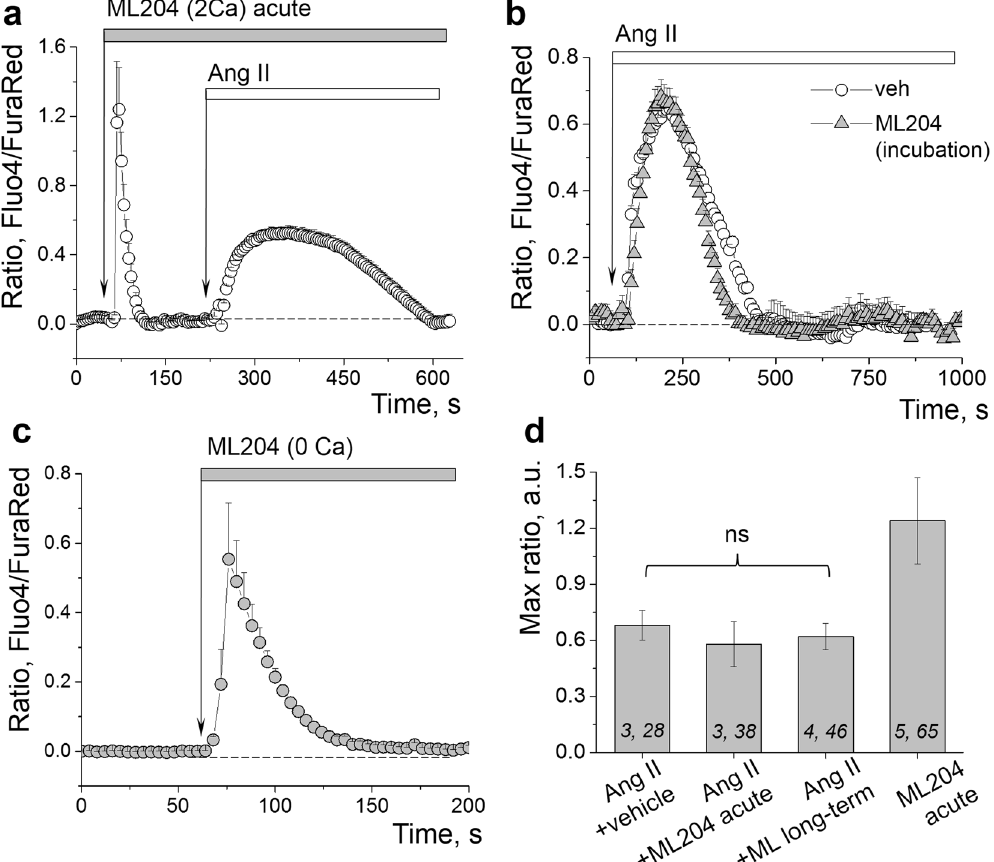
Figure 7. The effects of ML204 on calcium influx in the podocytes. ( a ) The representative effect of acute applications of 20 µ M ML204 followed by 10 µ M Ang II on Ca 2 + level in the podocytes (in calcium-containing media). ( b ) Representative effect of ML204 (20 µ M, 10 min incubation) on Ca 2 + transient evoked in the podocytes by 10 µ M Ang II. ( c ) The representative effect of the acute application of 20 µ M ML204 on Ca 2 + level in the podocytes in calcium-free solution. ( d ) Graph summarizing the effects of Ang II on calcium influx in the podocytes in presence of ML204, or an acute application of ML204 alone. ( i , j ) noted on graph is number of animals ( i ) and podocytes ( j ) analyzed in each group. ns denotes no statistically significant difference versus Ang II application in the absence of the